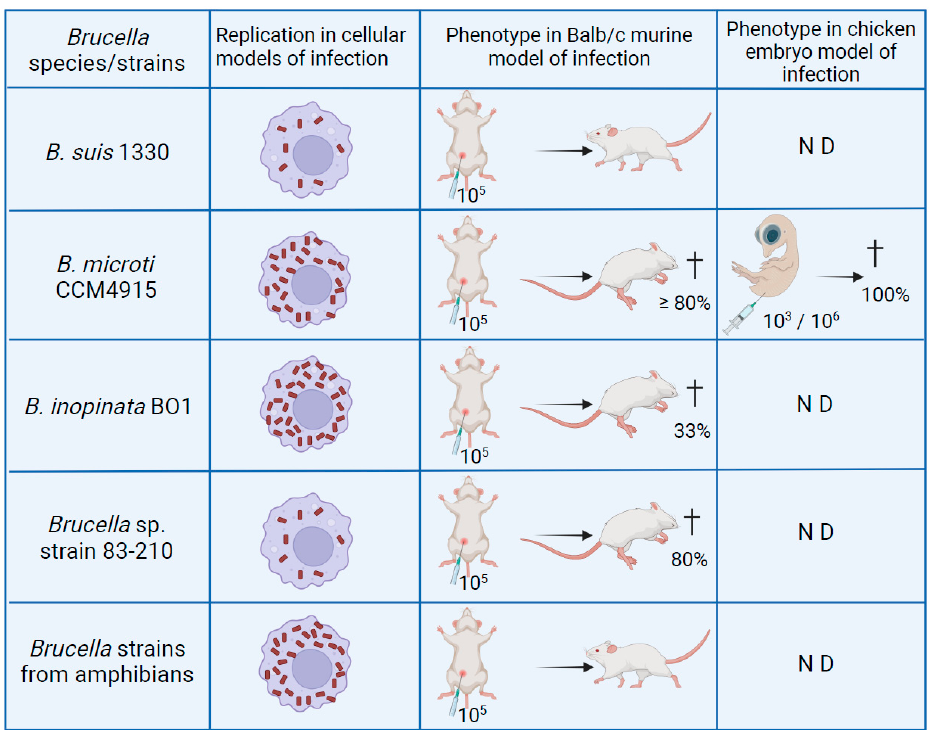
Figure 7. Novel Brucella spp. and strains in established infection models. Overview of the behavior of novel Brucella species and strains in cellulo and in the Balb/c murine model of infection, in comparison to the classical human pathogen B. suis bv. 1 strain 1330. Among the selected species, only B. microti has been studied in the chicken embryo model. Created with BioRender.com.